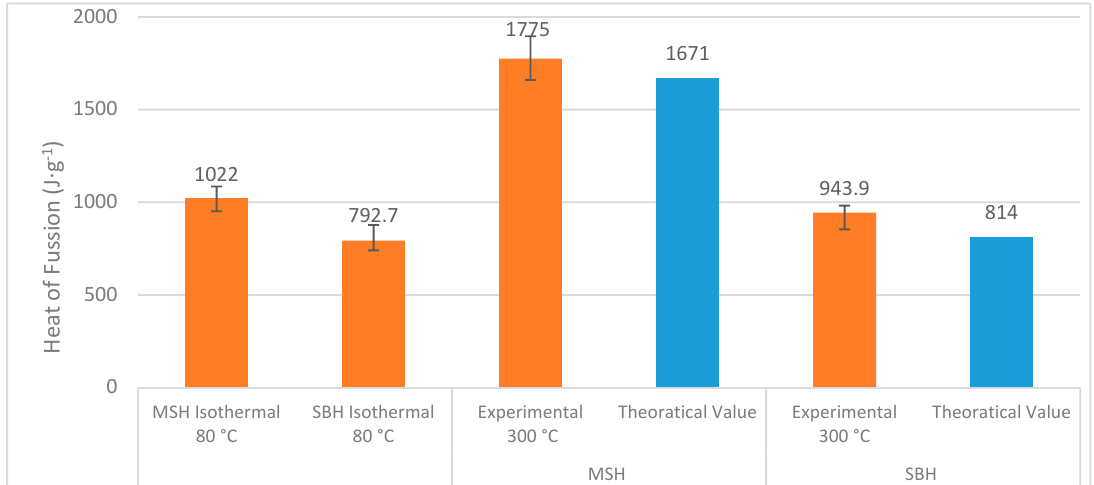
Figure 18. MSH’s and SBH’s heat of fusion obtained from different DSC techniques. Theoretical values were taken from the references given in Table 1, where the heat of fusion of the dehydrations accounts for 7 and 5 moles of water release from MSH and SBH, respectively. The experimental results show that the heat of fusion value corresponds to near complete dehydration of SBH and MSH at 300 °C. Each test was repeated three times.